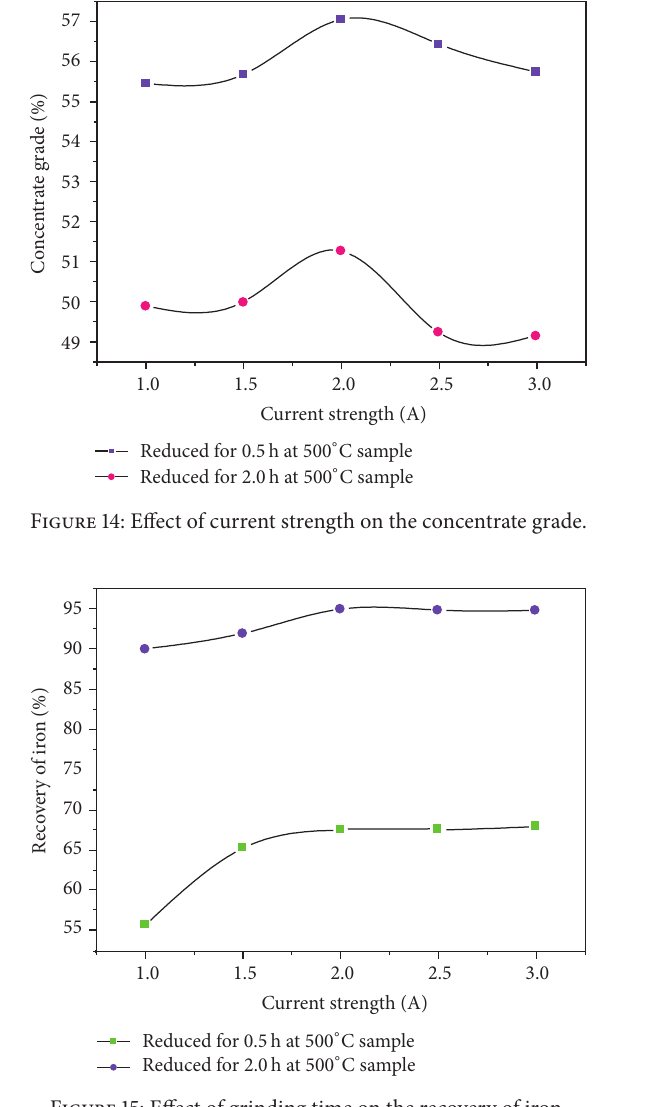
Figure 15: Effect of grinding time on the recovery of iron.